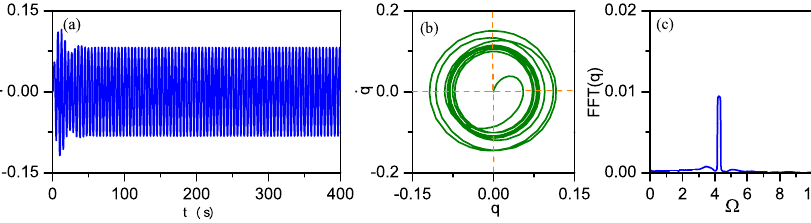
Figure 8. The primary resonance response with time delay τ = π /2, ( a ) The time history curves, ( b ) the phase diagram and ( c ) frequency power